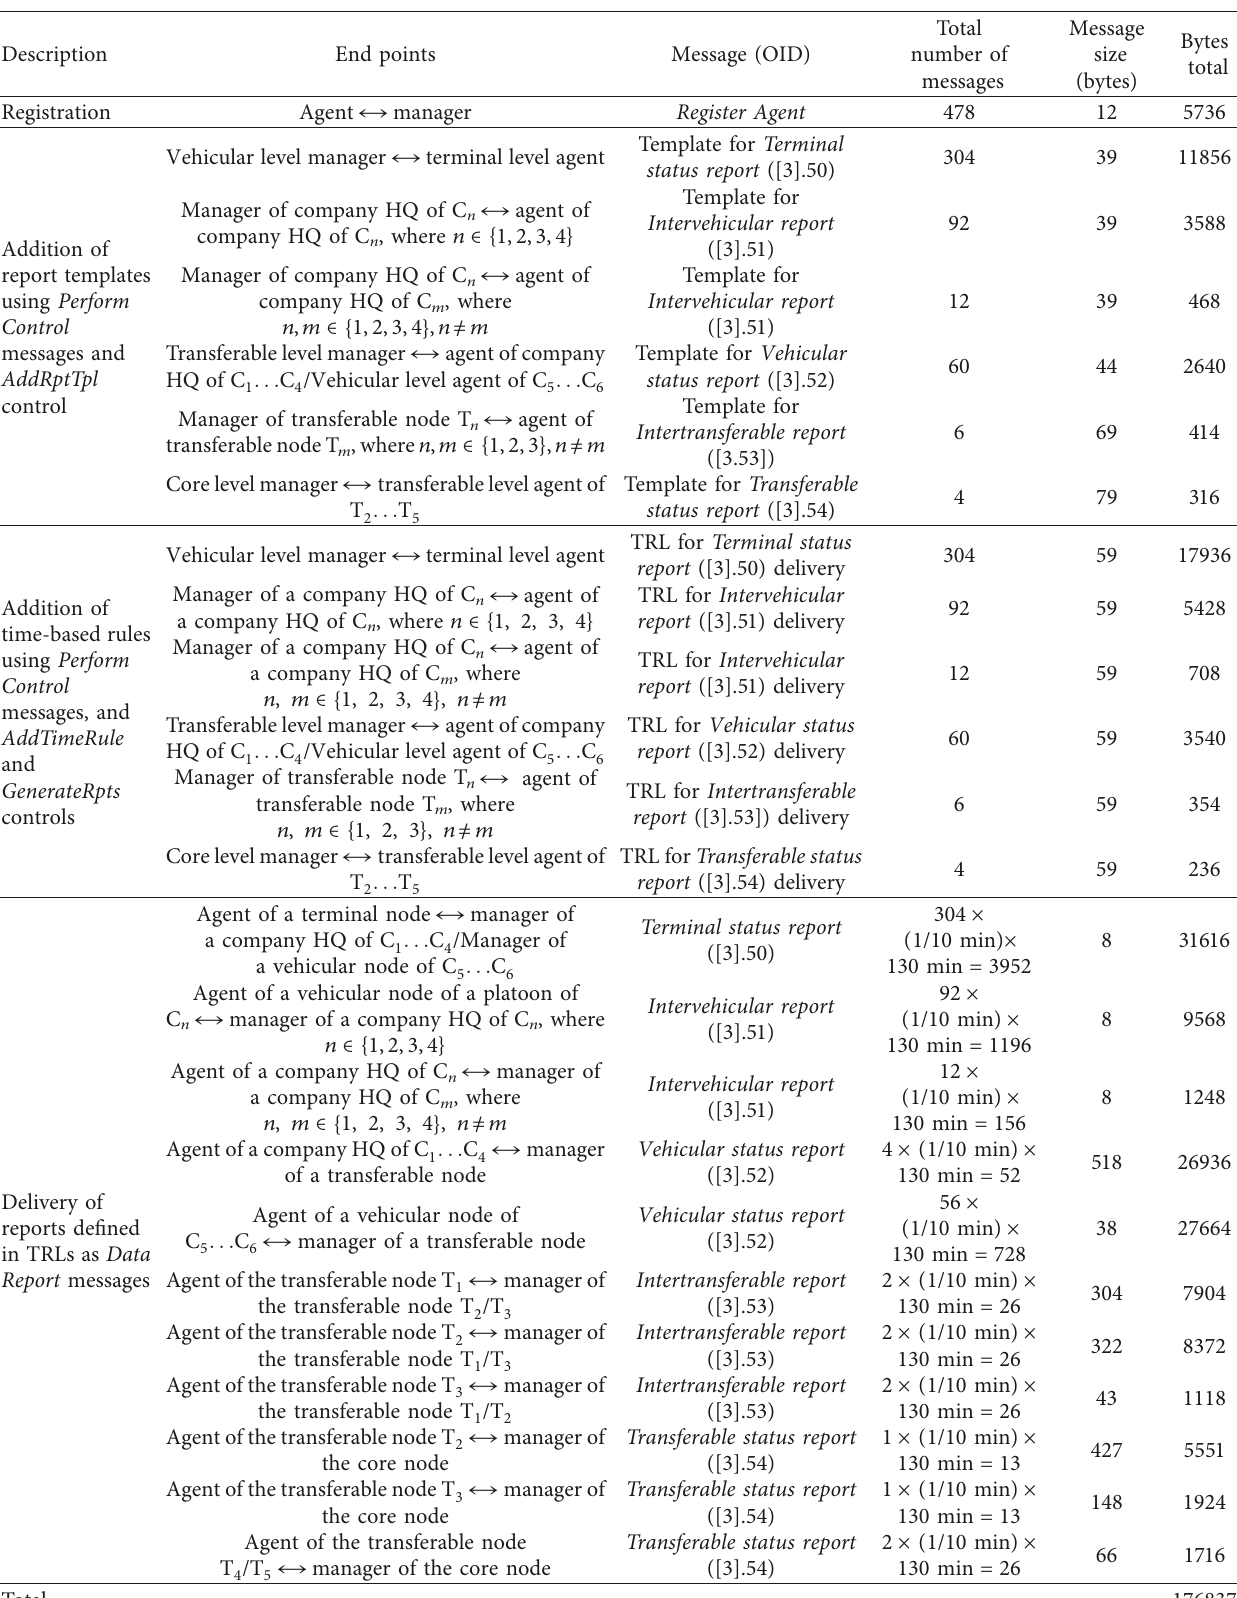
Table 5: Hierarchical DTN-level management messaging of the Anglova